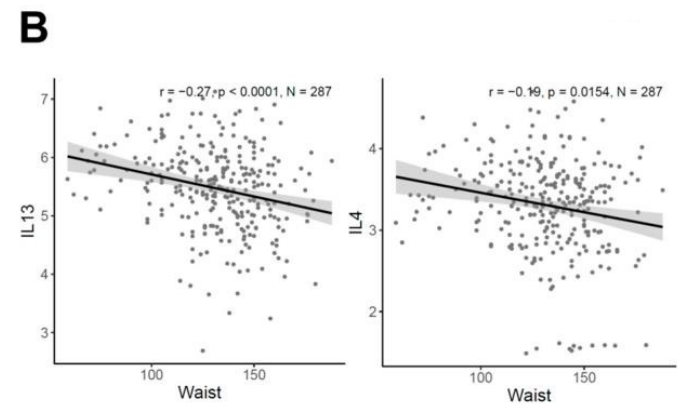
Figure 5. Human gene correlation analysis of visceral adipose tissues. The presented data are RNA-Seq data from human visceral adipose tissue samples (n = 1553). ( A ) Correlation analysis of fibrotic-related genes as well as IL13 and IL4 in visceral WAT. ( B ) Significant negative correlation of IL13 and IL4 with waist circumference (N = 287). Positive correlations are shown in blue while negative correlations are represented in red. The size of the dot refers to the degree of correlation; * p -value < 0.05; ** p -value < 0.01; *** p -value < 0.001.